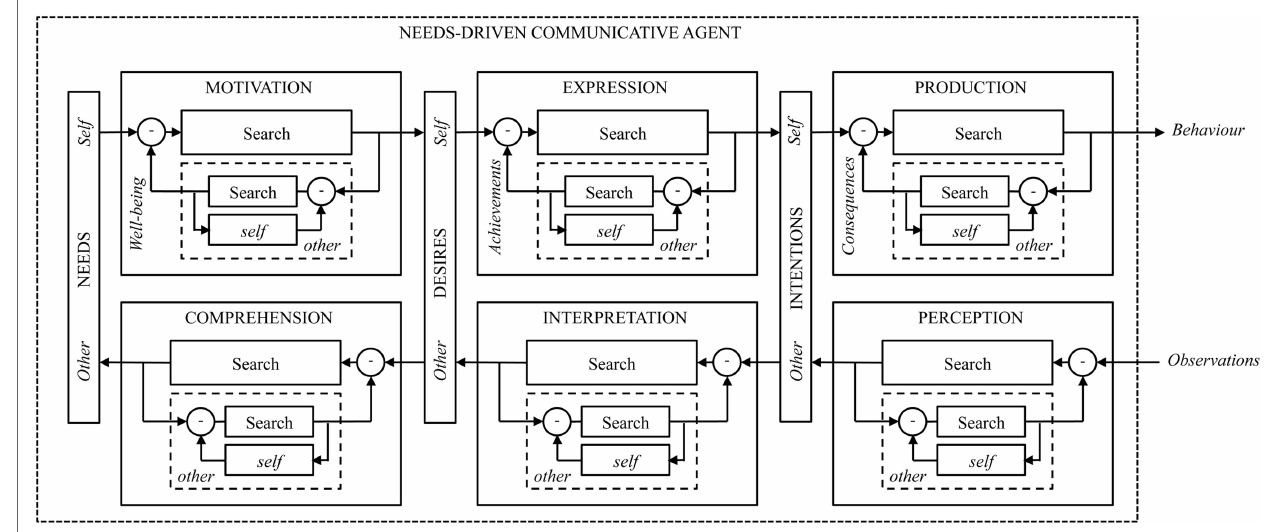
FIGURE 9 | Illustration of the derived architecture for a needs-driven communicative agent (Moore,